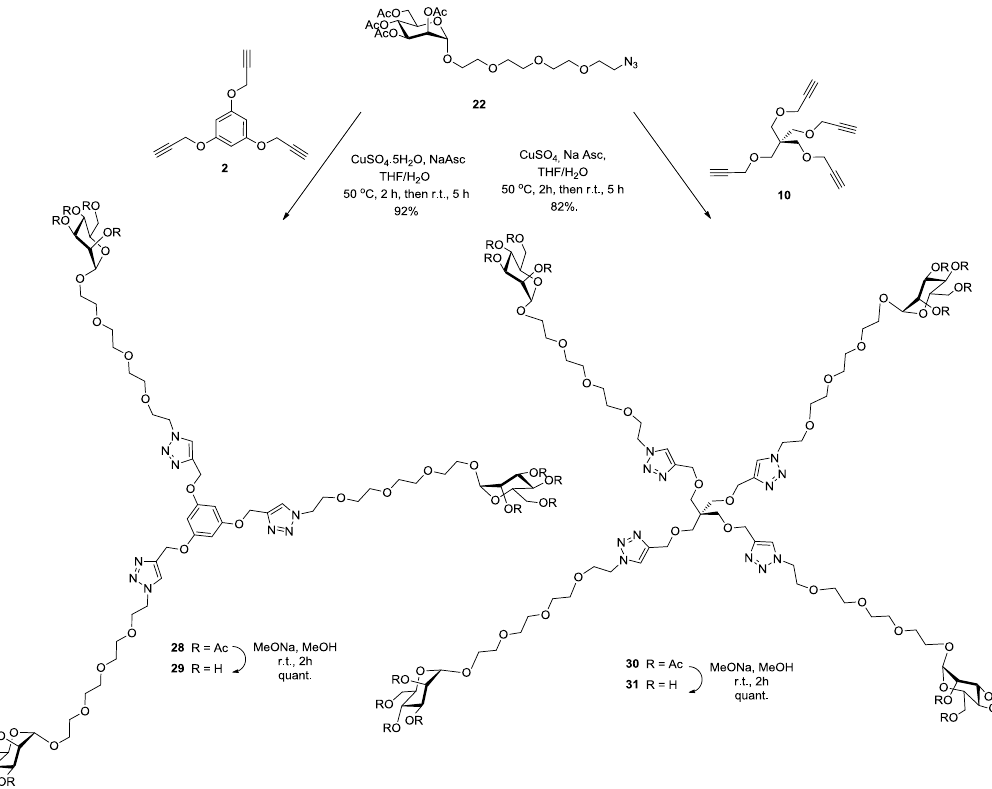
Scheme 6. Synthesis of tri- ( 29 ) and tetra-valent ( 31 ) pegylated mannosylated clusters using click chemistry on trimer ( 2 ) and tetramer ( 10 ) scaffolds, respectively.